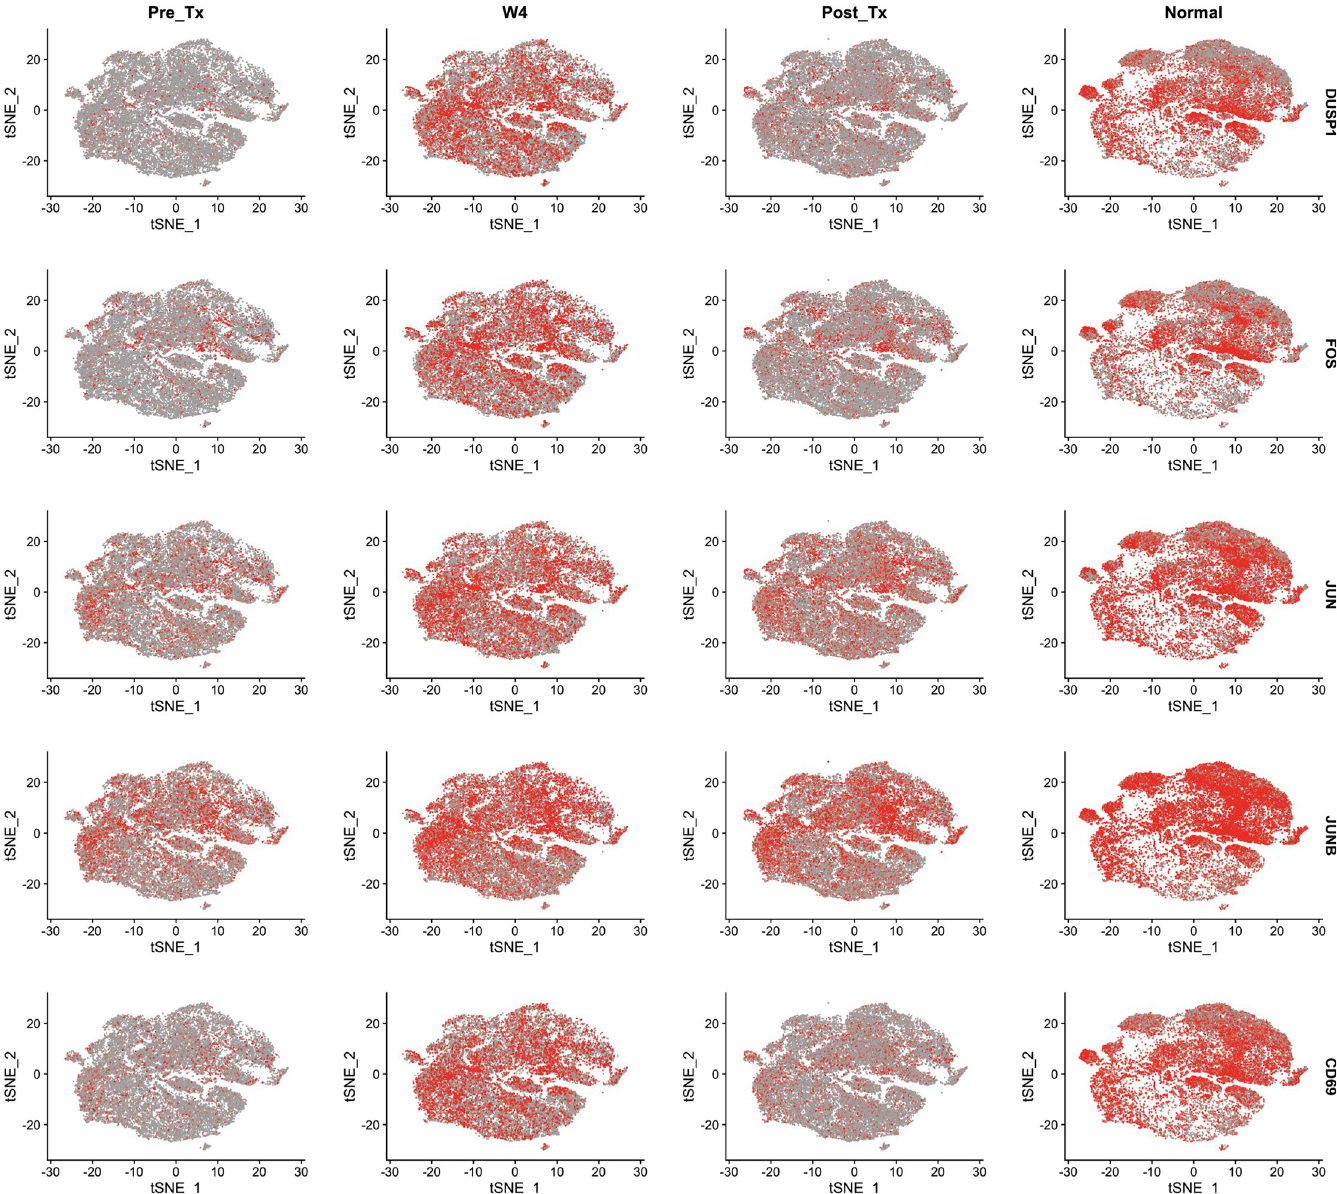
Fig 5. IFN-free DAA therapy results in a transient increase of several transcripts expression associated with T cell activation. Activation markers gene expression projected on tSNE plots. Cells are colored representing the relative gene expression of DUSP1 , FOS , JUN , JUNB or CD69 for each of the three time points (pre- treatment, week four of treatment, and post-treatment) and for normal controls. Colors indicate a gradient of gene expression, from red (high expression) to grey (low expression).